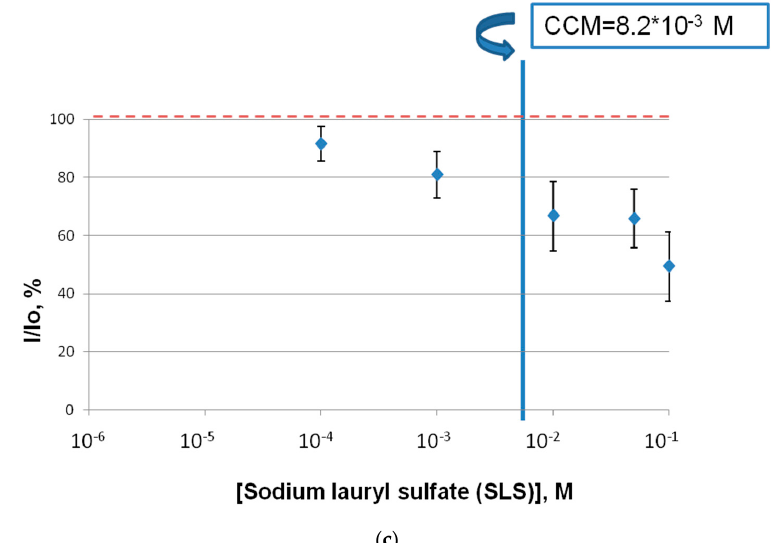
Figure 2. The residual luminescence intensity, I/I 0 , of the luminous bacterium P. phosphoreum in the presence of Tween 80 ( a ), CTAB ( b ) and SLS ( c ). The red dotted line means the values of light in- tensities of the luminous bacterium in the absence of the surfactants.